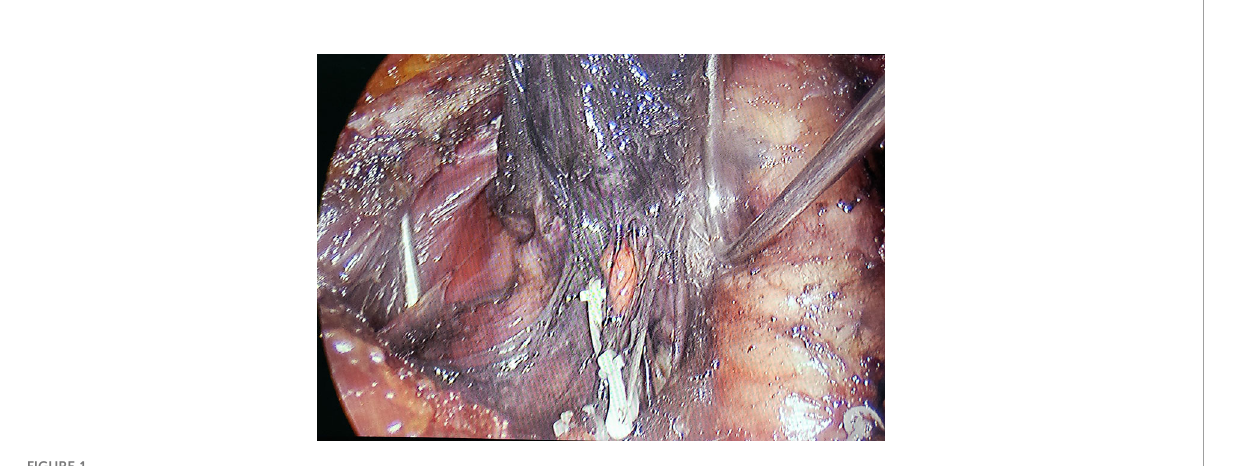
FIGURE 1 “ Negative imaging ” of parathyroid